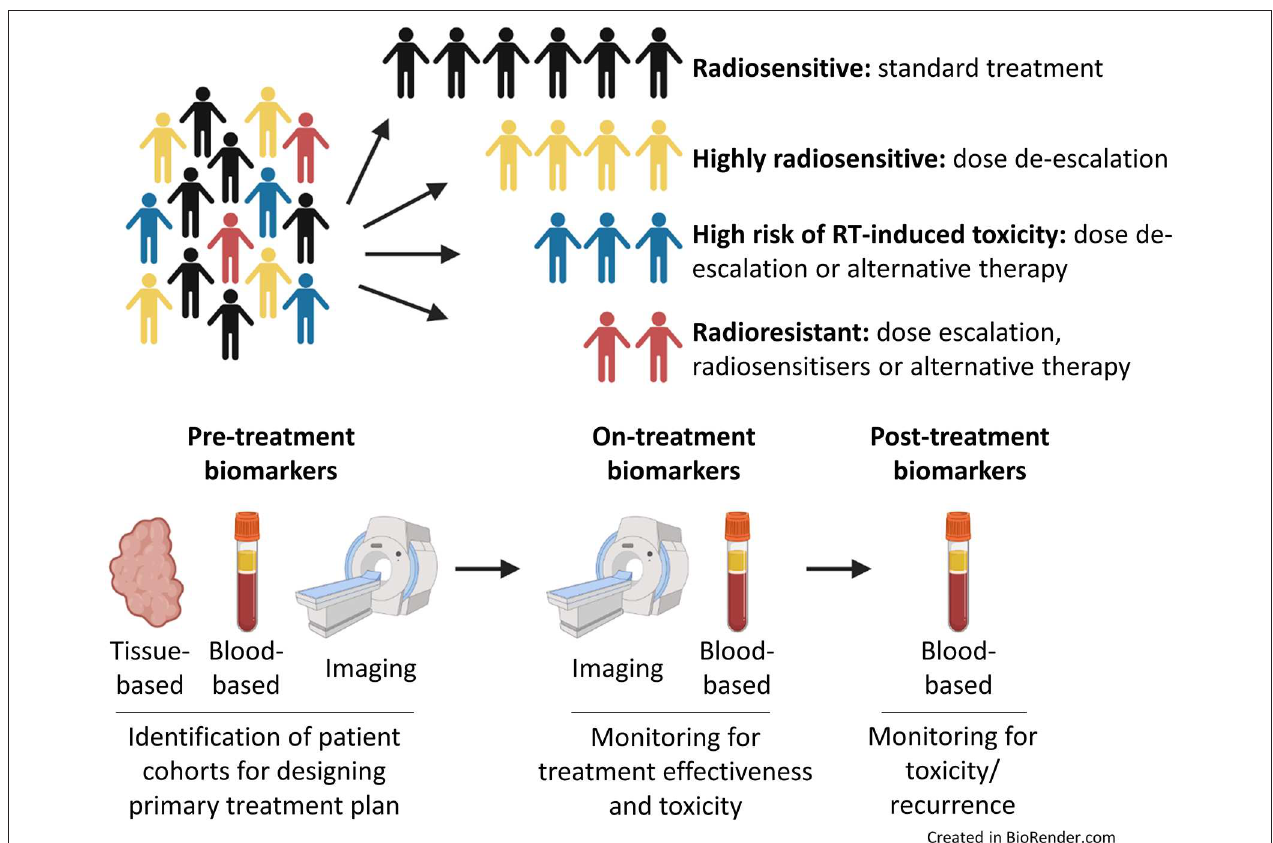
FIGURE 1 | Precision medicine and radiotherapy. Patients could be stratified into different cohorts based on predicted intrinsic radiosensitivity and risk of toxicity. On-treatment monitoring may provide information on response to treatment, enabling adaptive changes to a patient’s treatment to be made if necessary. Post-treatment biomarkers could be used to assess for evidence of toxicity, tumor recurrence or the development of metastatic